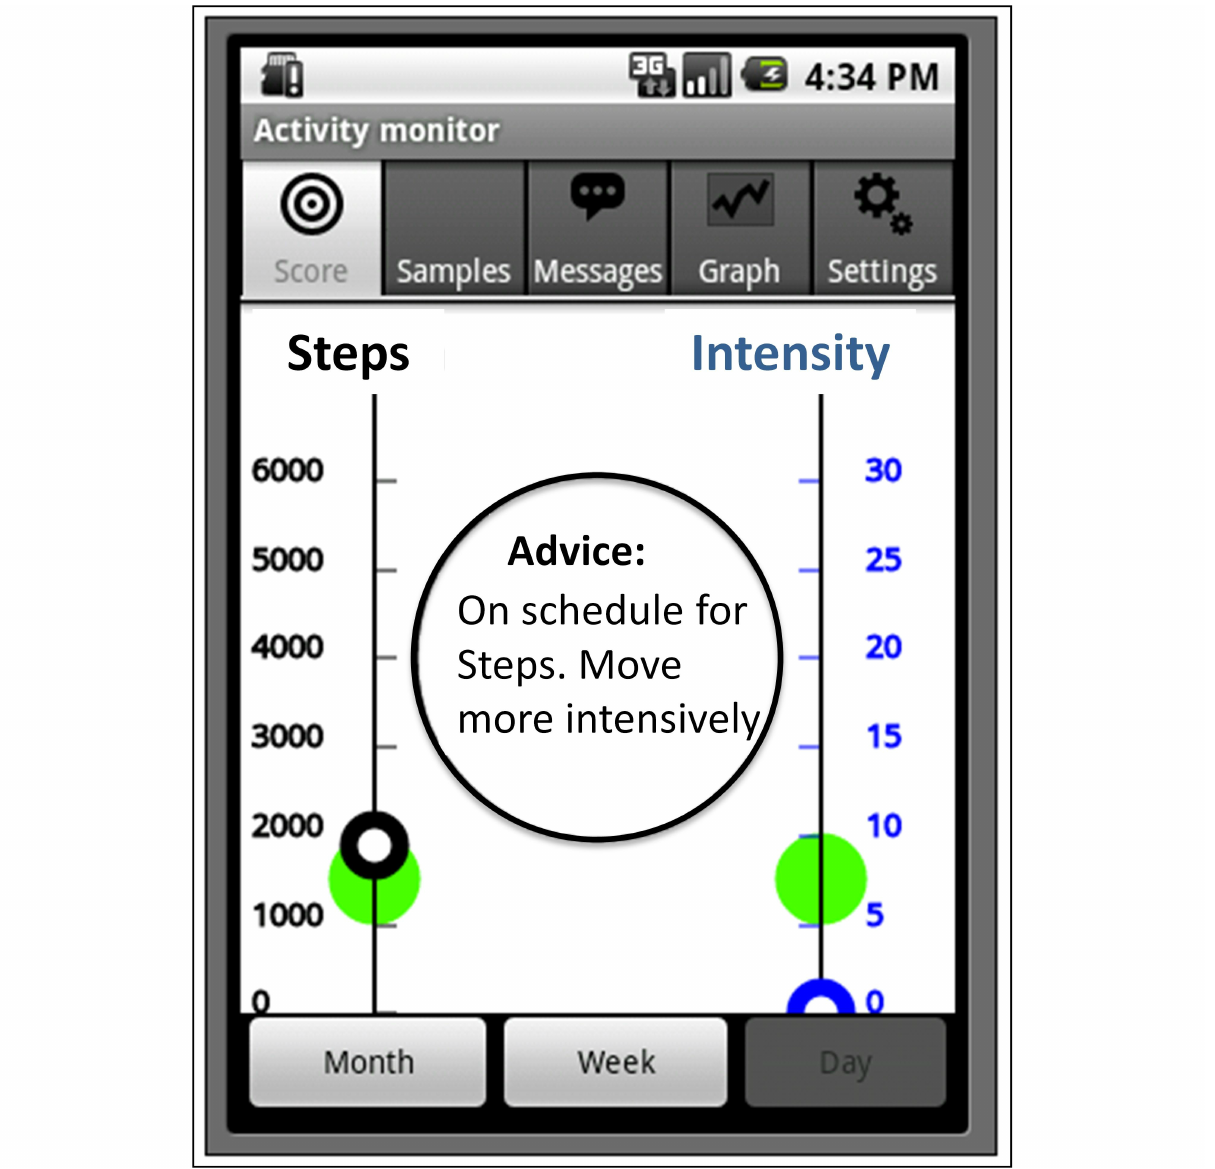
Figure 3. In version 2, the left axis shows amount of steps, while the right axis gives a measure of intensity. The DPA goal is reached when the open circles (representation of current activity status) are kept in the rising green circles at all times (pilot study